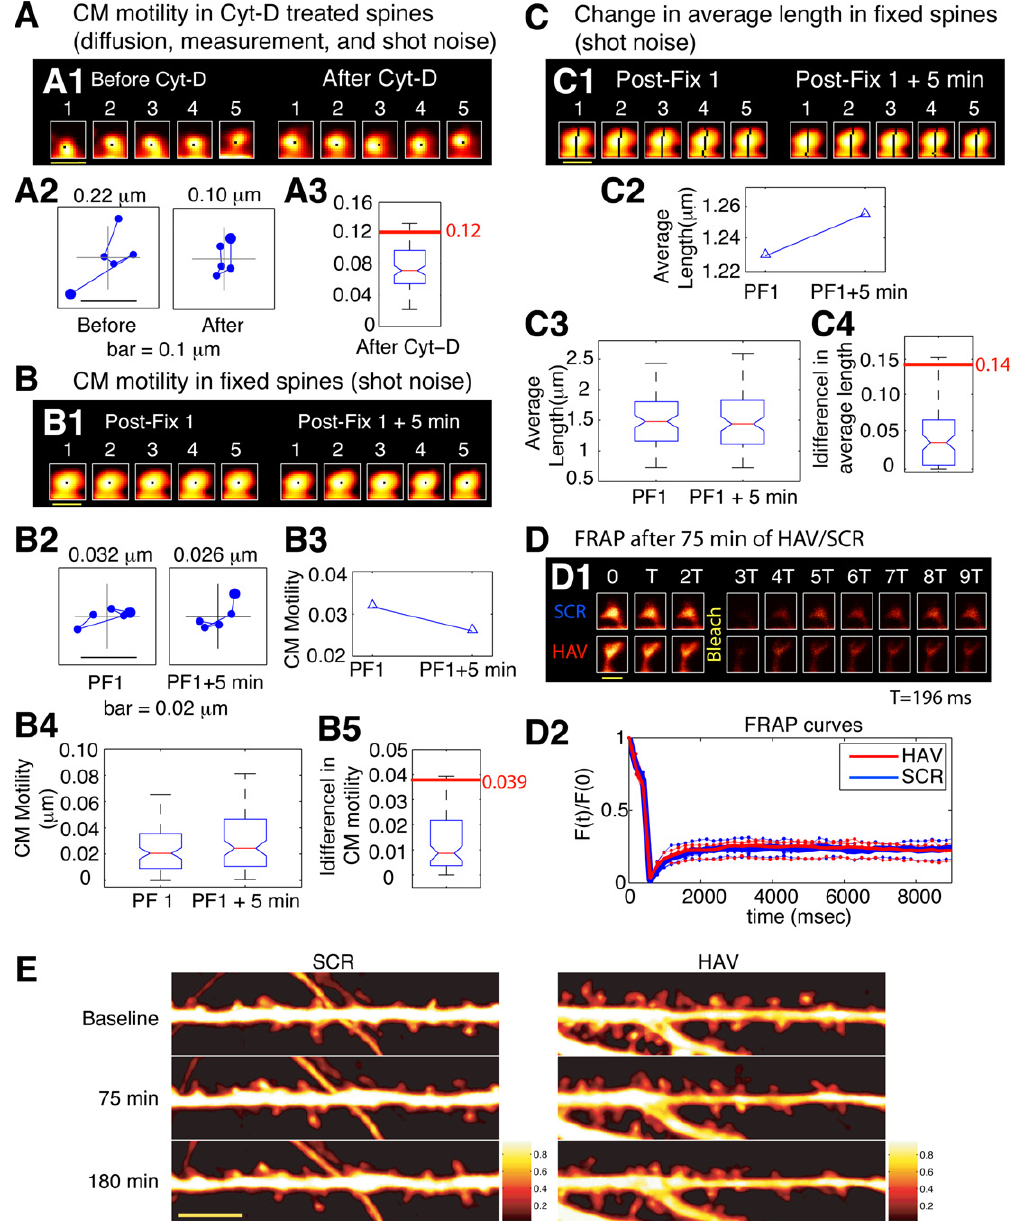
Figure 3. Estimation of noise-fl oors. (A) Estimate of noise in the measurement of center-of-mass motility of spines. (A1) Time-lapse images of a repre- sentative spine from an EGFP-expressing neuron before and 20 minutes after treatment with cyt-D (2 μ M). (A2) Each panel shows the locus of successive instantaneous center-of-mass positions over the 5 minutes within a time-point (after translational normalization to center the locus at the origin). The large dot represents the position of the spine at the fi rst minute within that time-point. The locus in each panel gives a visual indication of the extent to which the spine is motile. The center-of-mass motility value (net movement) of the spine within a time-point is indicated in microns. Cyt-D application causes a reduction in center-of-mass motility, as expected. (A3) Box plot showing the distribution of center-of-mass motility after cyt-D treatment ( n = 229 spines). The 95-percentile value in this distribution (0.12 μ m) was chosen as the noise threshold. (B) Estimate of noise in the change in center-of-mass motility. (B1) Time-lapse images of a representative spine at two time-points after fi xing neurons and immunostaining EGFP-expressing neurons. (B2) Loci of the instantaneous center-of-mass positions of the example spine in (B1) within each of the two time-points (left and right panels respectively). The numbers in microns indicate total movement at that time-point. The difference between these two values is small, as expected. (B3) Center-of-mass motility of the example spine in (B1) at two time-points. (B4) Box plots showing the distributions of center-of-mass motility values at the two time-points after fi xation ( n = 128 spines). (B5) Box plot of the distribution of the absolute difference between the center-of-mass motility values measured at the two time-points. The 95-percentile value of this distribution (0.039 μ m) noise was chosen as the noise threshold for change in center-of-mass motility. (C) Estimate of noise in the change in average length of spines. (C1) Time-lapse images of the example spine shown in (B1) with the instantaneous centerlines. (C2) Average length of the spine at two time-points. (C3) Box plots showing the distributions of spine average length values at the two time-points after fi xation ( n = 128 spines). (C4) Box plot of the distribution of the absolute difference between average length values measured at the two time-points. The 95-percentile value of this distribution (0.14 μ m) noise was chosen as the noise threshold for change in average length. (D) Fluorescence recovery after photobleaching (FRAP) of EGFP. (D1) Time-lapse images of representative spines from HAV- and SCR-treated cells showing FRAP. (D2) Individual FRAP curves from four spines for each of the two treatments (red dots – HAV, blue dots – SCR) along with the average FRAP curves for each treatment (thick solid lines). Scale bar = 1 μ m. (E) Time-lapse images of dendritic segments from neurons treated with SCR and HAV respectively. Scale bar = 5 μ